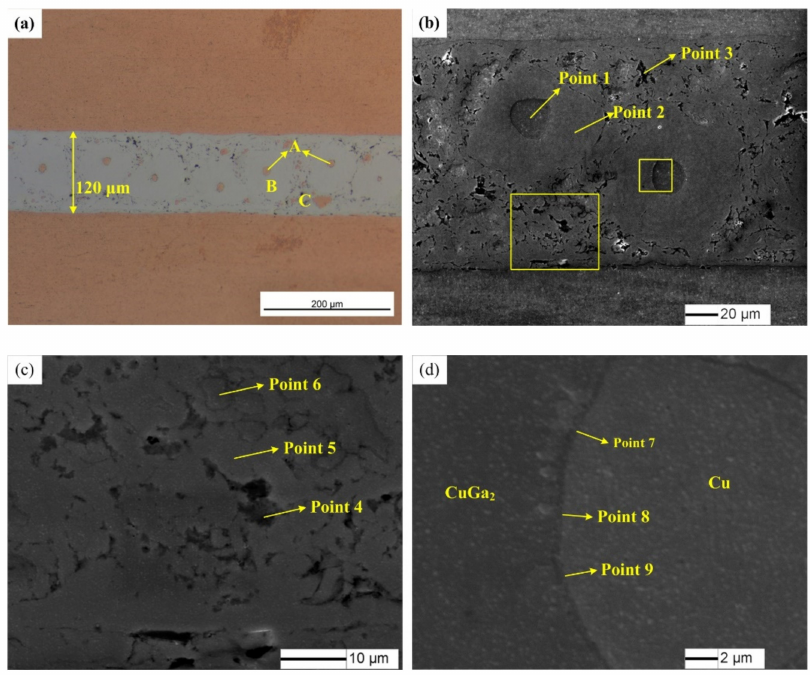
Figure 5. ( a ) Optical microscope image of the joint after bonding for 20 h at 100 ◦ C; ( b – d ) SEM images of the joints after bonding for 20 h at 100 ◦